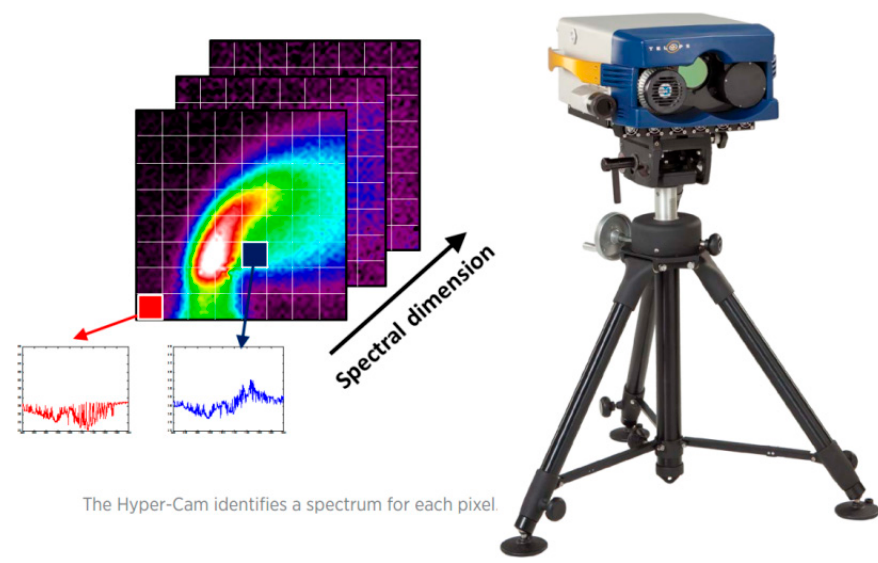
Remote Sens. 2022 , 14 , x FOR PEER REVIEW Figure 1. Picture of the long-wavelength Hyper-CAM instrument. Figure 1. Picture of the long-wavelength Hyper-CAM instrument.